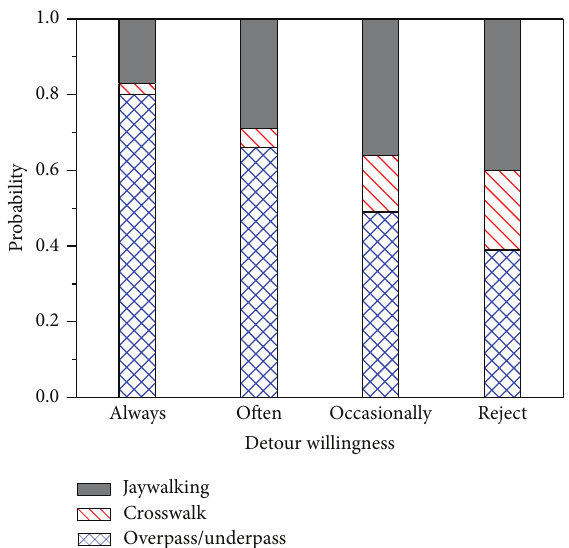
Figure 3: Probability of each alternative with different detour willingness.